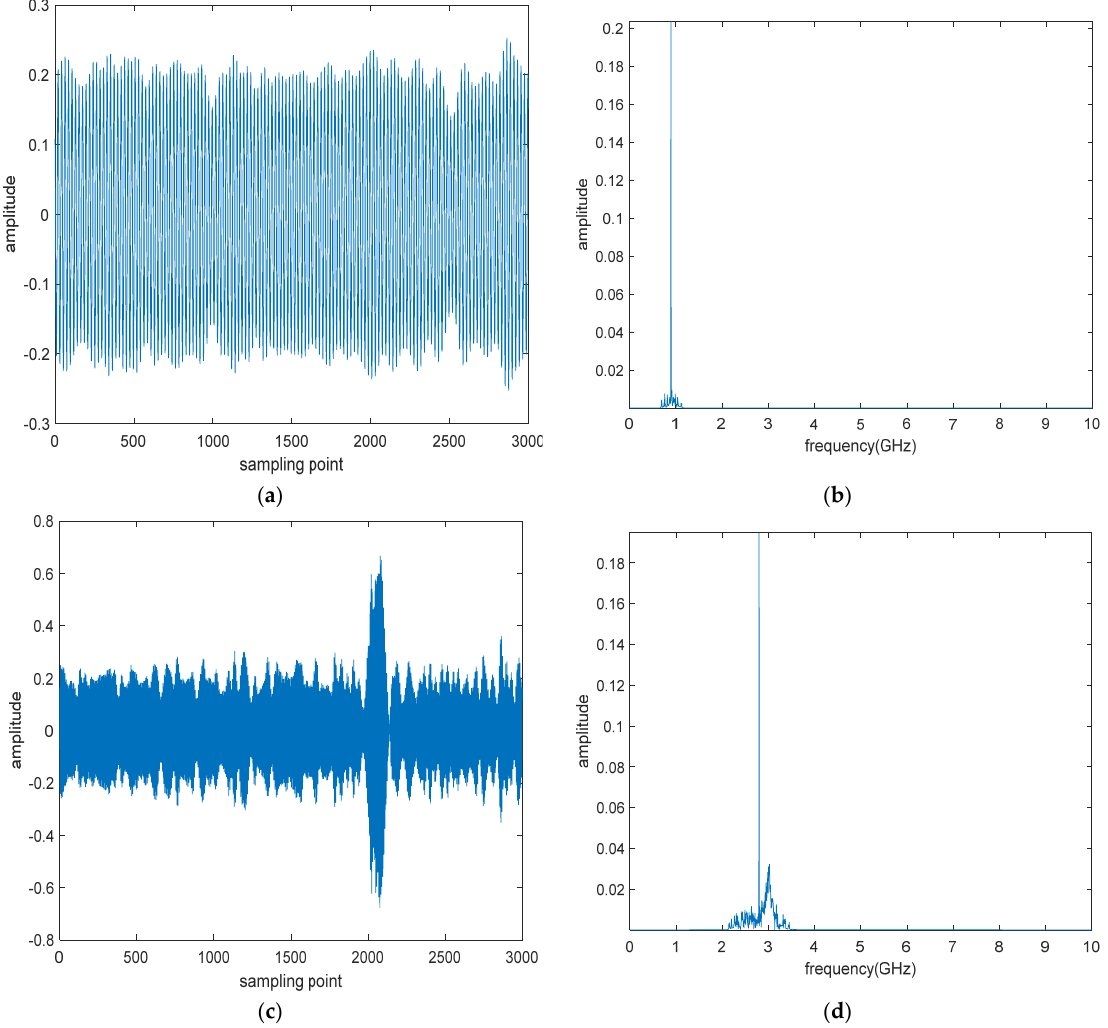
Figure 12. The refined synthetic signals. ( a ) srec1 in time domain, ( b ) srec1 in frequency domain, ( c ) srec2 in time domain, and ( d ) srec2 in frequency